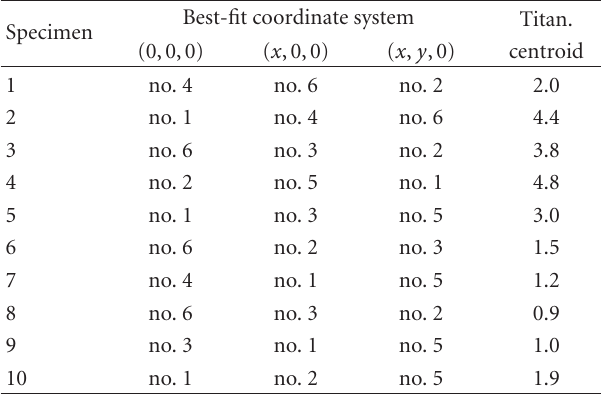
Table 3: The best-fit matching results in µ m of the cast frameworks to their respective master casts using the unfixed method of align-